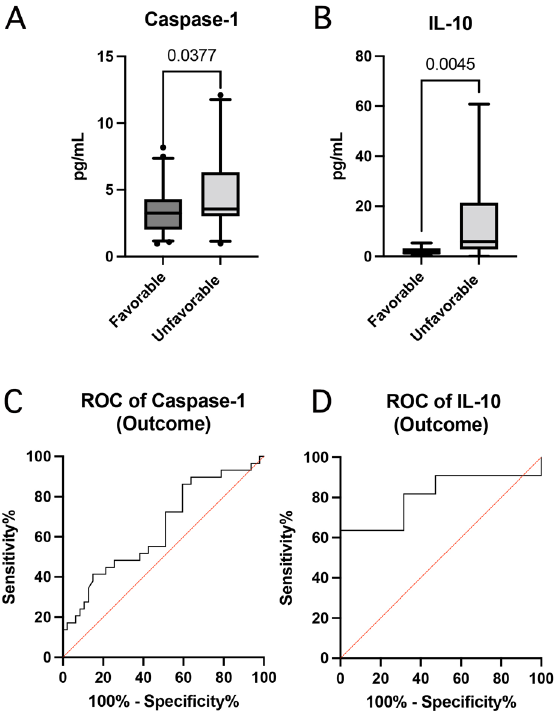
Figure 5. Inflammatory biomarkers as predictors of TBI outcome. Box and whisker plots showing the protein levels in pg/mL of caspasea-1 ( A ) and IL-10 ( B ) as a biomarker of outcome after TBI. Box and whiskers are shown for the 5th and 95th percentile. Dots correspond to data points outside the 5th and 95th percent confidence interval. ROC curves indicate the AUC (sensitivity vs. 1-specificity) for ( C ) caspase-1: Favorable: N = 47, Unfavorable: N = 29 and ( D ) IL-10: Favorable: N = 19, Unfavorable: N = 11.